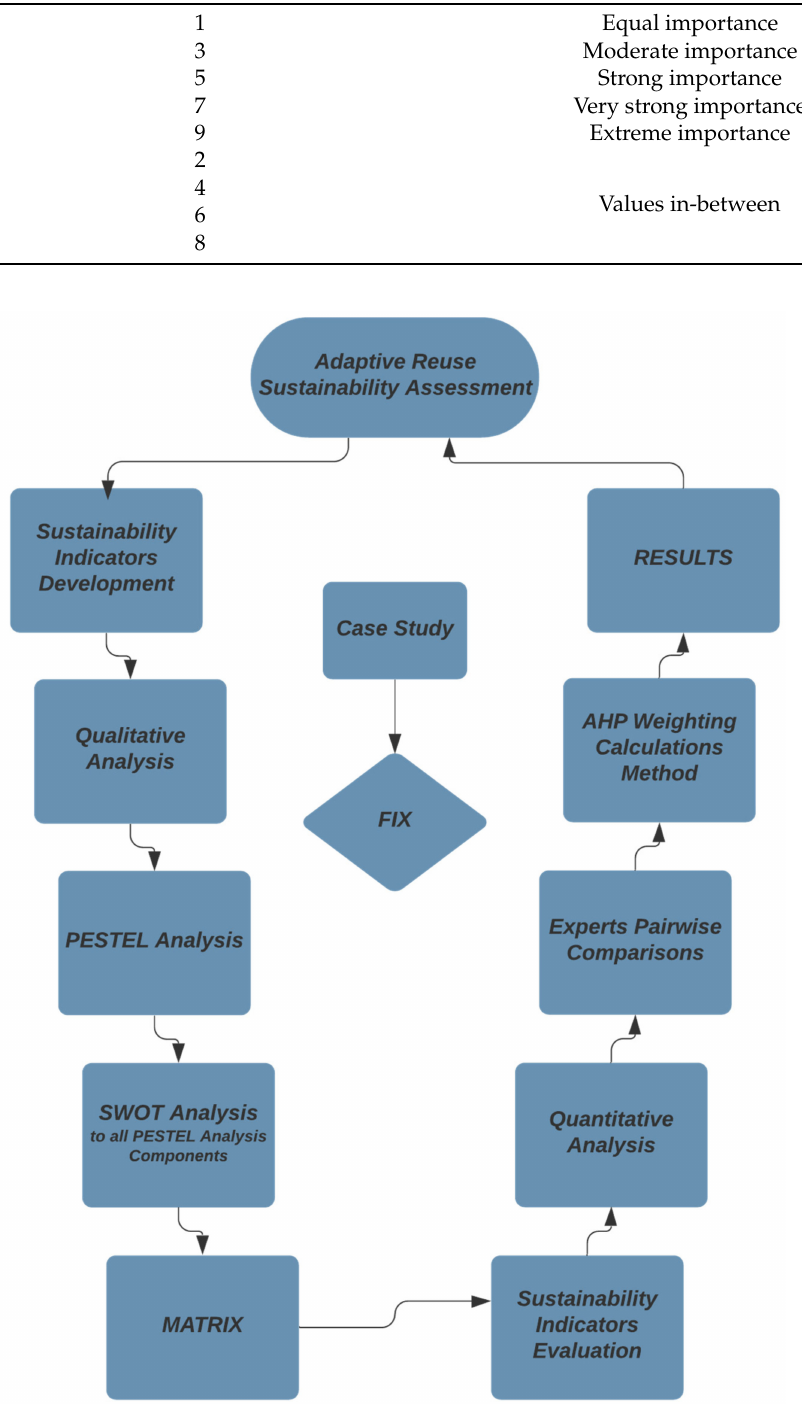
Figure 3. Methodology conceptual flow